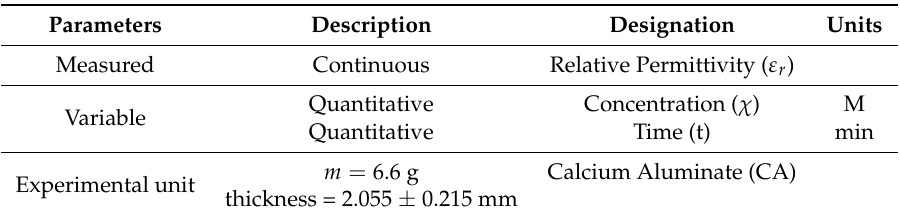
Table 2. Experimental parameters for CA